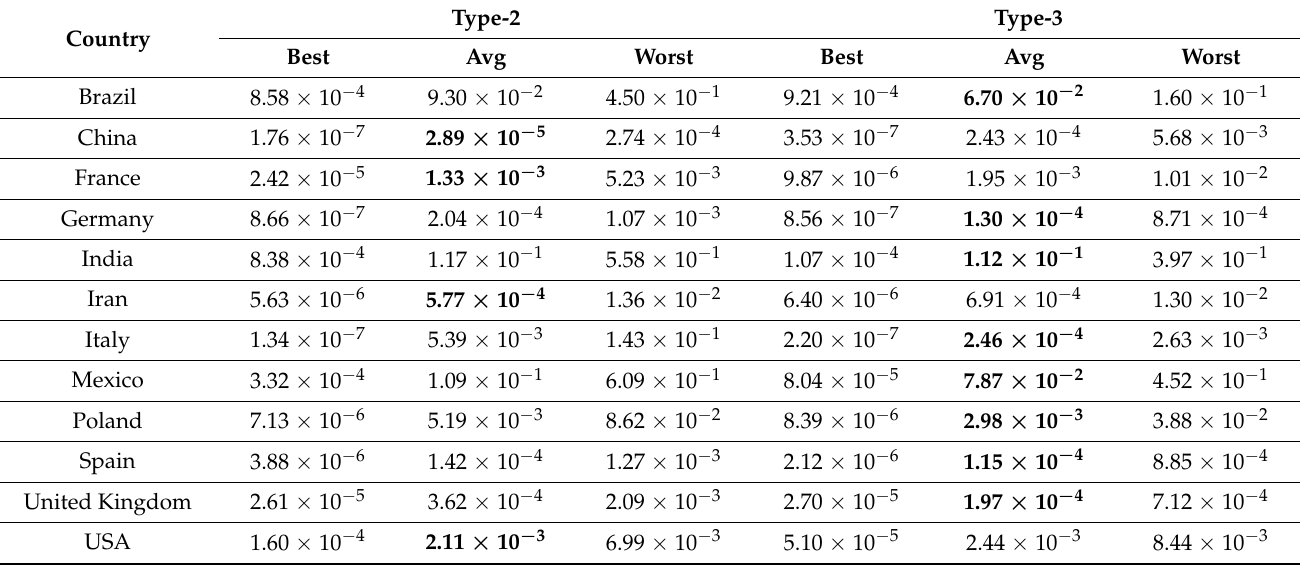
Table 15. Second data period (future